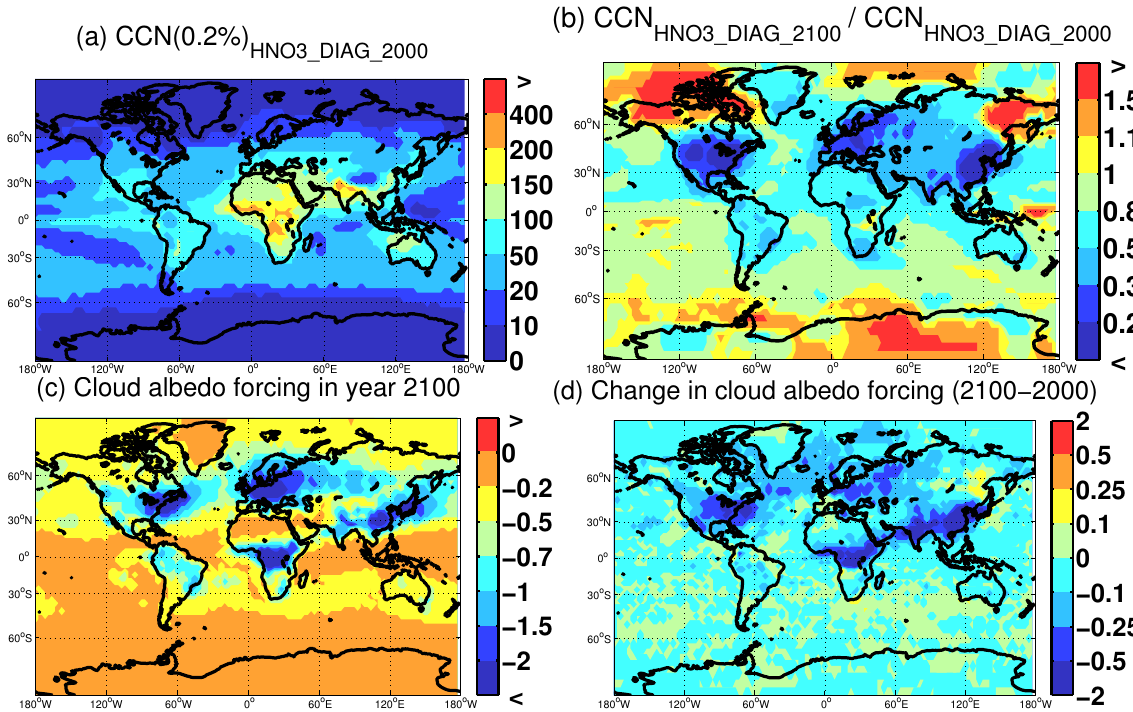
Fig. 5. ( a) Surface-level CCN(0.2%) (cm − 3 ) in year 2100 (HNO3 DIAG 2100), (b) ratio of CCN(0.2%) between years 2100 and 2000 (experiments HNO3 DIAG 2100 and HNO3 DIAG 2000), (c) cloud albedo forcing (Wm − 2 ) due to nitric acid in year 2100 (experiment HNO3 DIAG 2100), and (d) the change in cloud albedo forcing due to nitric acid (Wm − 2 ) between years 2000 and 2100 (negative values indicate more cooling due to nitric acid in year 2100). The change in (d) is calculated as a difference of nitric acid cloud albedo forcing in experiments HNO3 DIAG 2100 and HNO3 DIAG